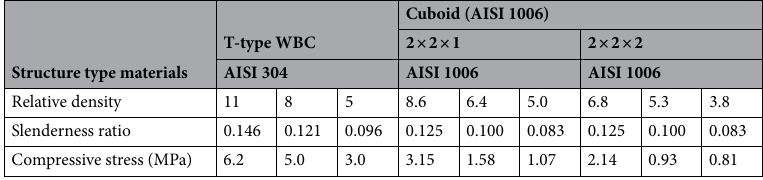
Table 5. Performance comparison between wire-weaving and proposed wire-bending